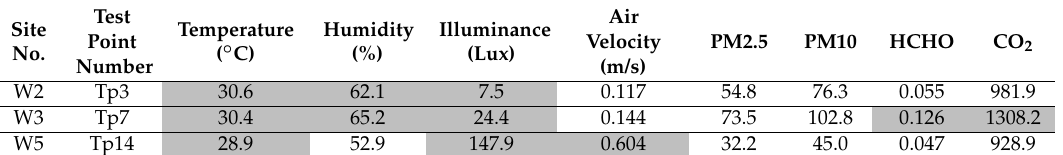
Table 6. Average values for the physical test results from the tube entrance (connection to a building).